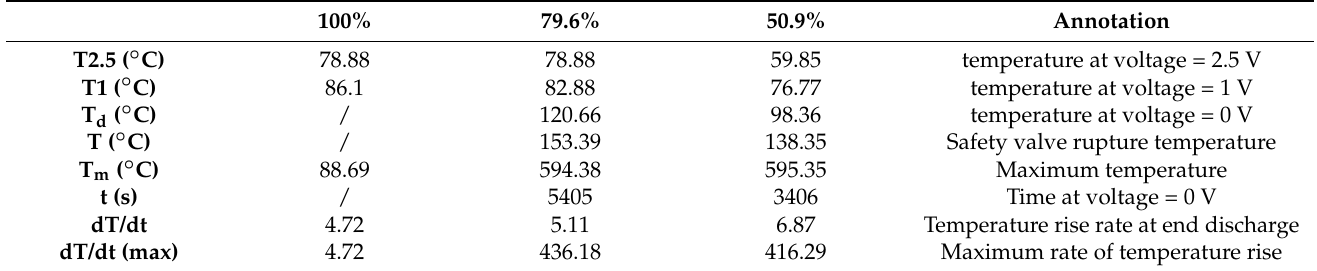
Table 2. Thermal runaway characteristic parameters of NCM811 battery with different